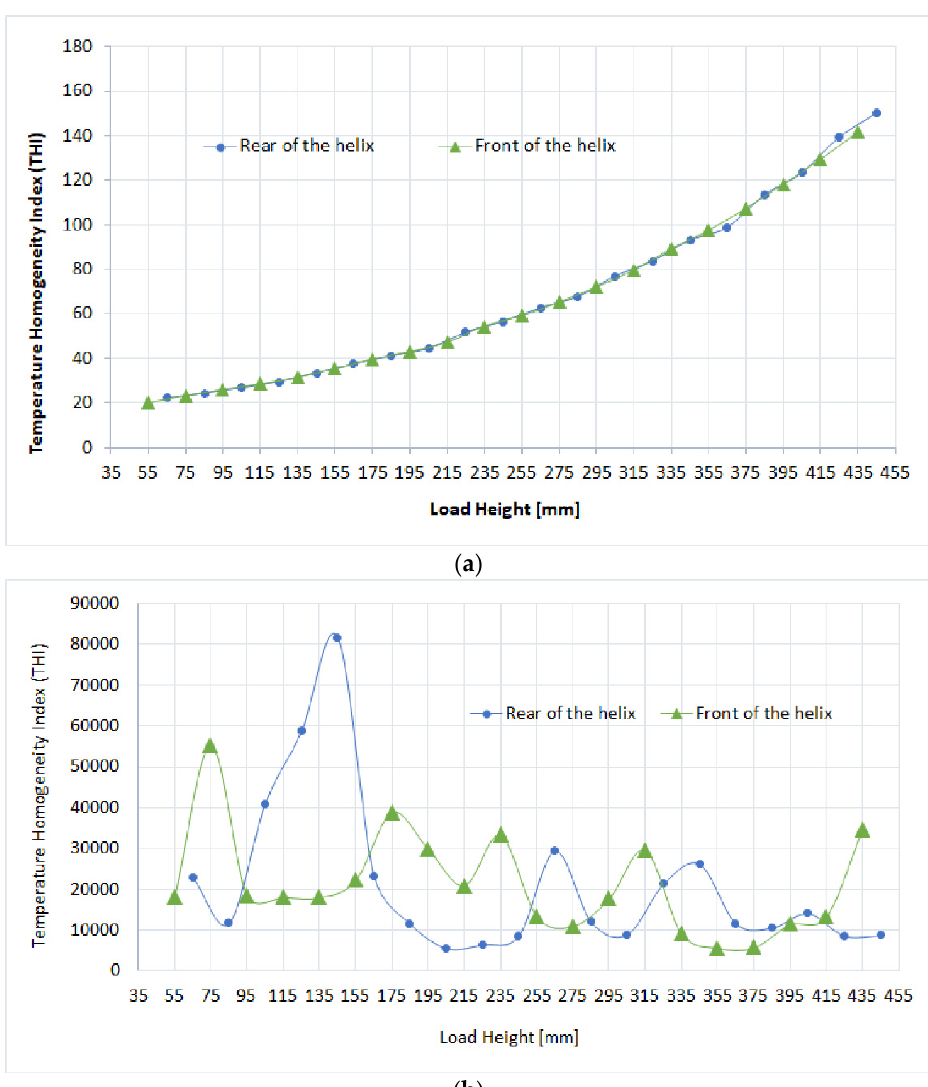
Figure 7. Temperature homogeneity index (THI) as function of the height of the load inside the helix: ( a ) conventional heating; ( b ) microwave heating.